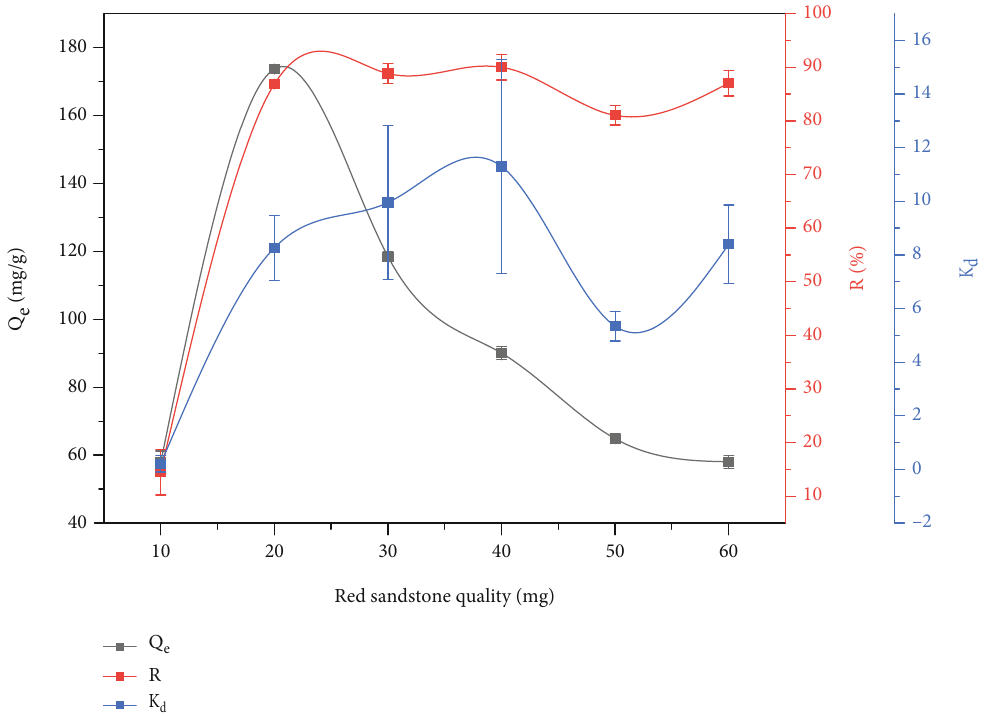
Figure 8: The e ff ect of red sandstone mass on the adsorption of 293K and 303K is only 125mg/g and 128mg/g, respectively. taken for adsorption tests. The test results are shown in Figure 10. When GO concentration is 120mg/L, the adsorp- tion capacity is up to 137.0mg/g at 313K, while that at